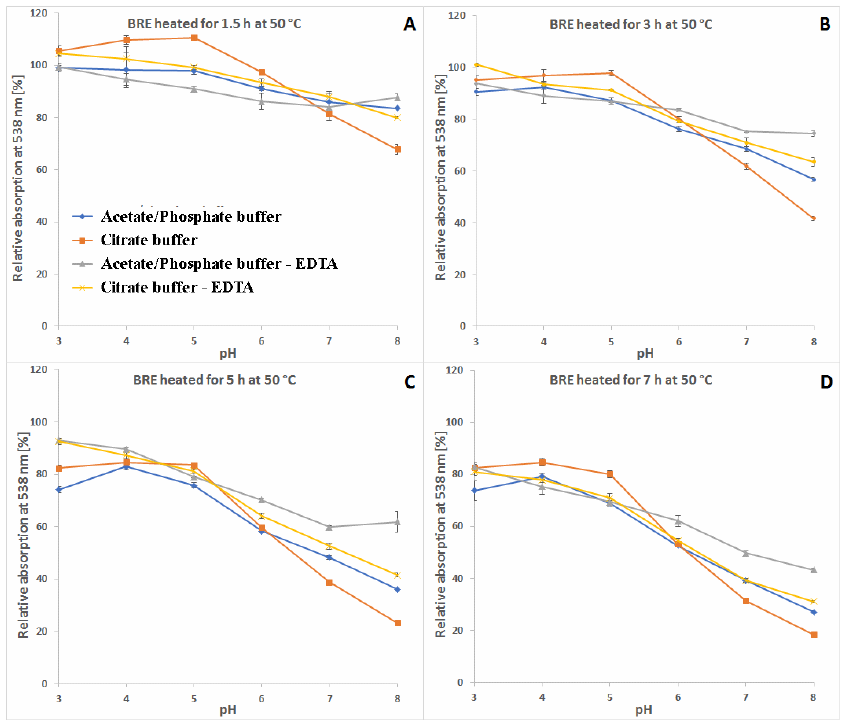
Figure 5. Relative absorption of red-violet pigments monitored at λ 538 nm after 1.5 ( A ), 3 ( B ), 5 ( C ) and 7 h ( D ) of heating (50 ◦ C) of betalain-rich extract (related to its starting value before heating) in acetate/phosphate and citrate buffers with optional addition of